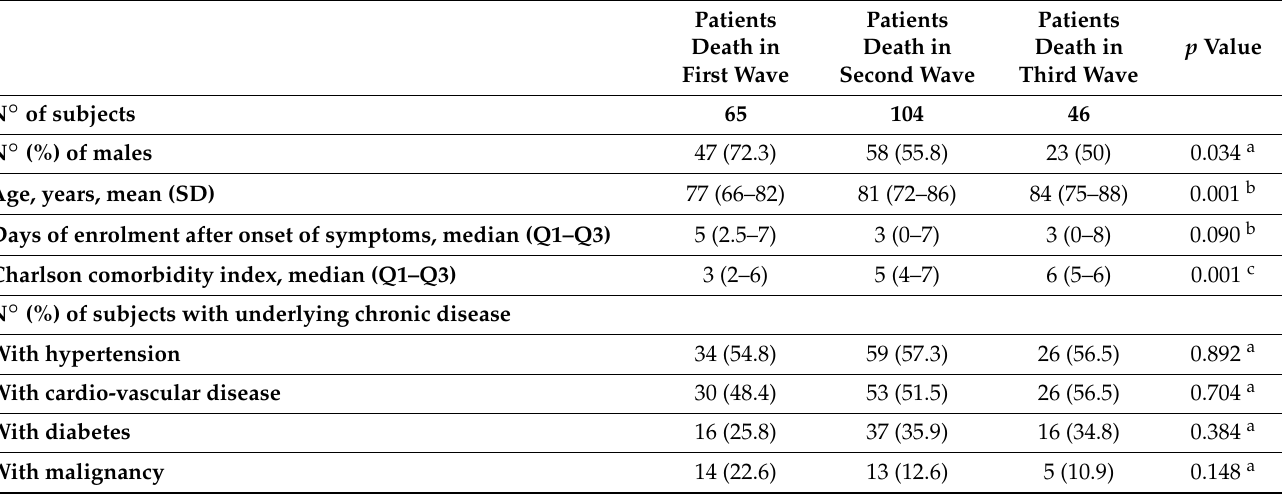
Table 3. Demographic, clinical and hematobiochemical data of patients who died during hospitaliza- tion, divided by the period of